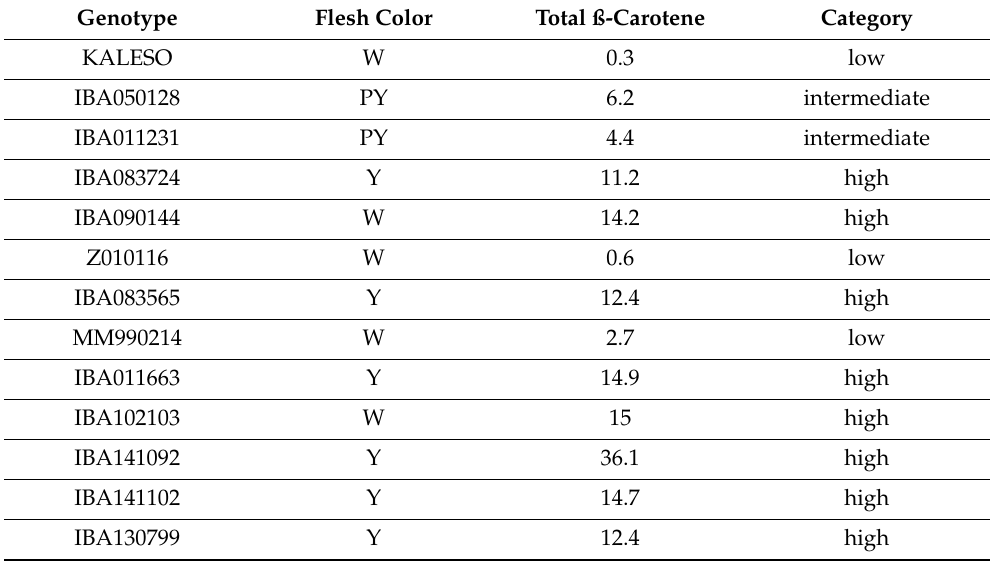
Table 1. Genotypes classification as low, intermediate, and high carotenoid content in storage roots based on the UHPLC–DAD–ToF–MS analysis. Three plants per genotype were analyzed. W: white, PY: pale yellow, Y: yellow.